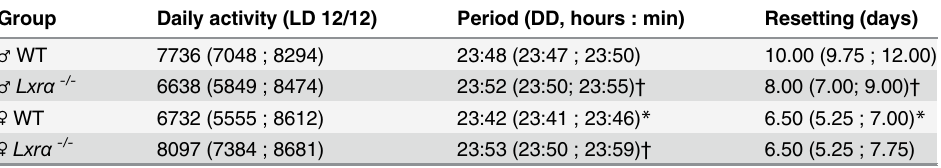
Table 2. Total daily activity, free-running period of locomotor activity and resynchronization time of WT and Lxr α -/- mice.